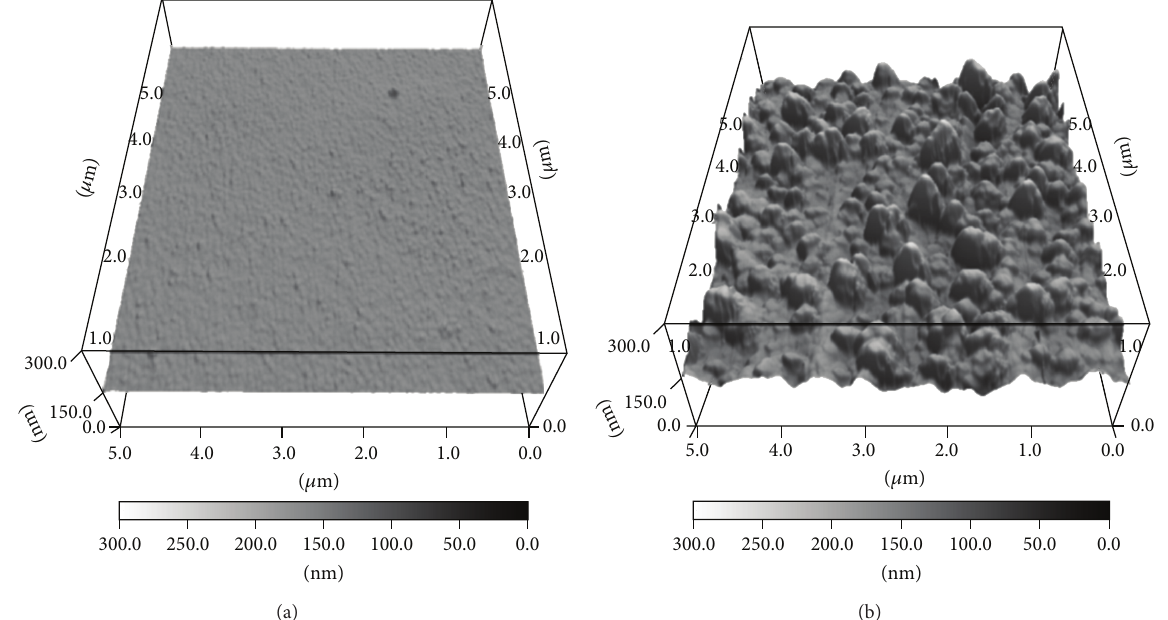
Figure 4: AFM images of Mo-Te thin films as-deposited (a) and (b) annealed at 475 ∘ C for 15min in N 2 ambient.